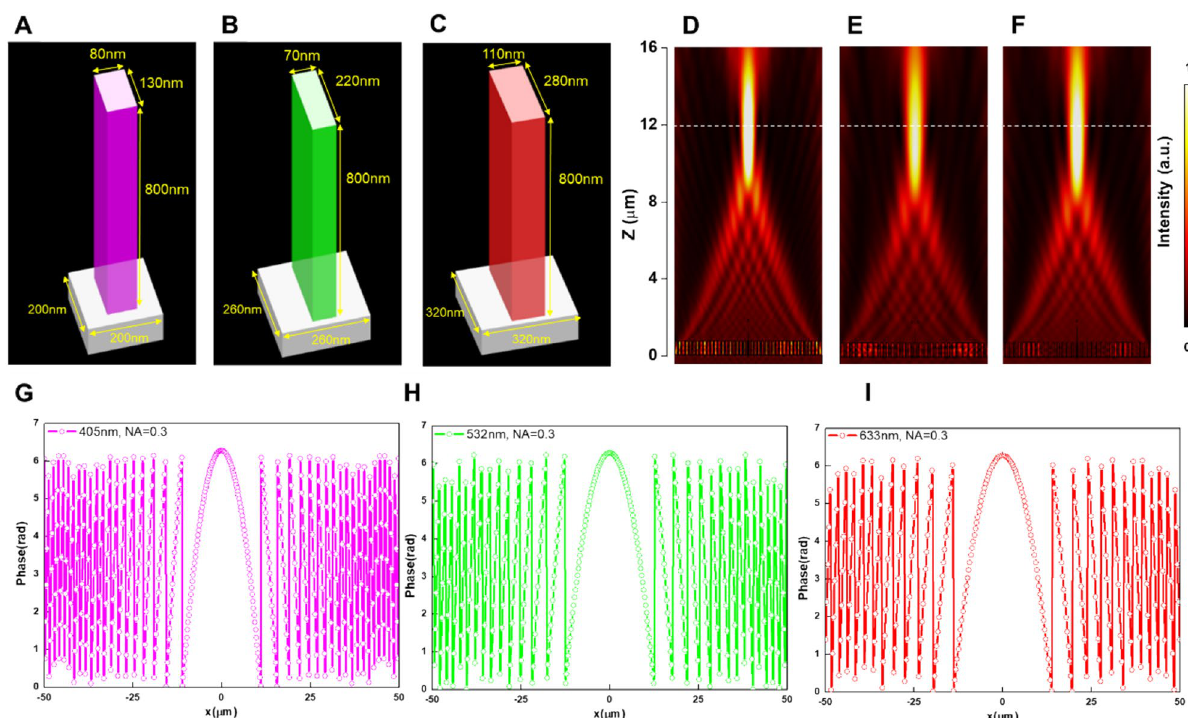
Figure 1. Design and simulation of metalenses. ( A – C ) Schematics of the metalenses building blocks designed at wavelengths of ( A ) 405, ( B ) 532, and ( C ) 633 nm. ( D – F ) Numerical intensity profiles of the metalenses designed at wavelengths of ( D ) 405, ( E ) 532, and (F) 633 nm. ( G – I ) Phase profiles for the metalenses designed at wavelengths of ( G ) 405, ( H ) 532, and ( I ) 633